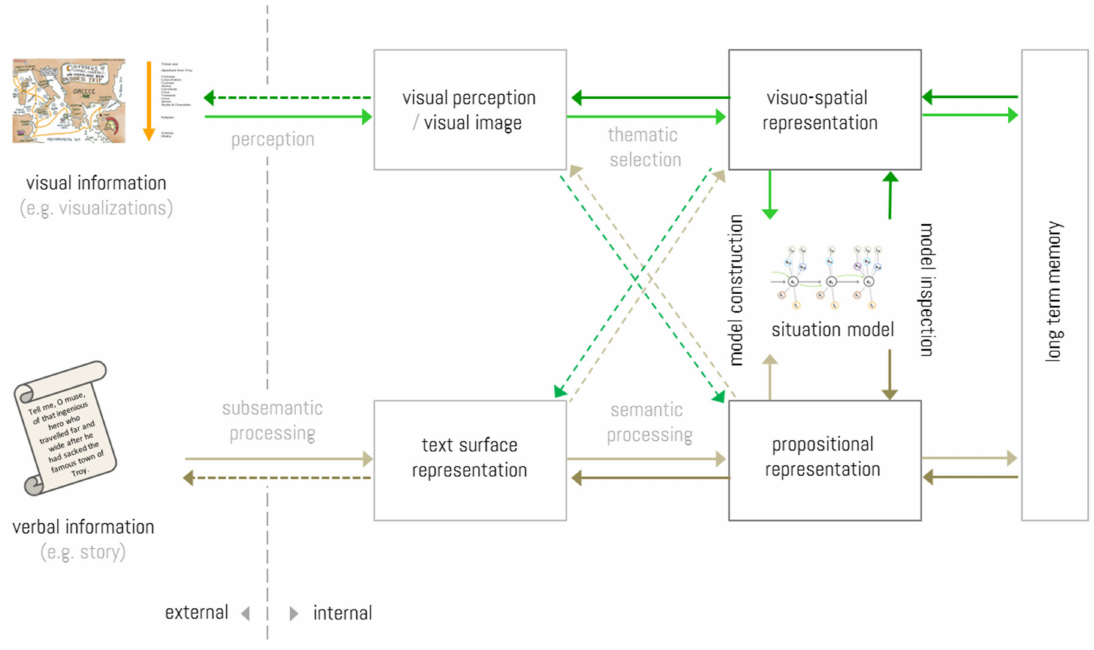
Figure 3. Model of multimodal cognition (Schnotz, 2014) adapted for the internalization of storytelling